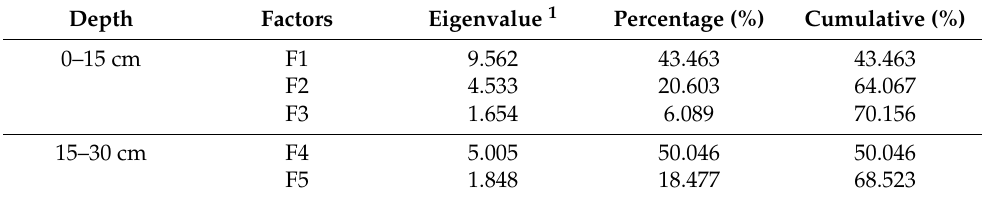
Table 4. Eigenvalue, percentage, and cumulative variance explained by factor analysis using the correlation matrix of the standardized data of soil parameters at 0–15 cm (F1, F2 and F3) and at 15–30 cm (F4 and F5)